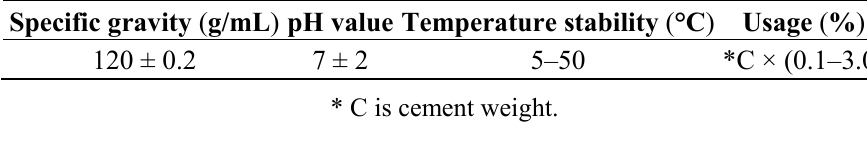
Table 5. Physical properties of superplasticizer.